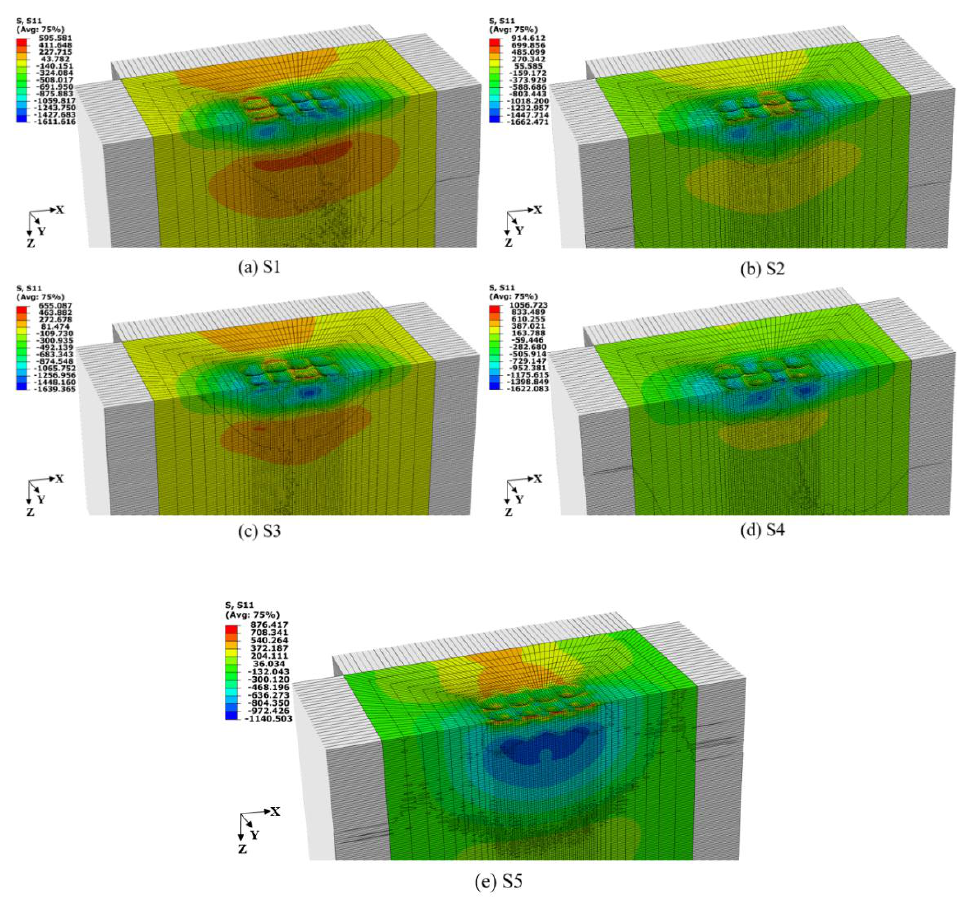
Figure 12. Contour plots of the residual stress state evaluated in X-direction for five different impact sequences: ( a ) S1; ( b ) S2; ( c ) S3; ( d ) S4; ( e ) S5.